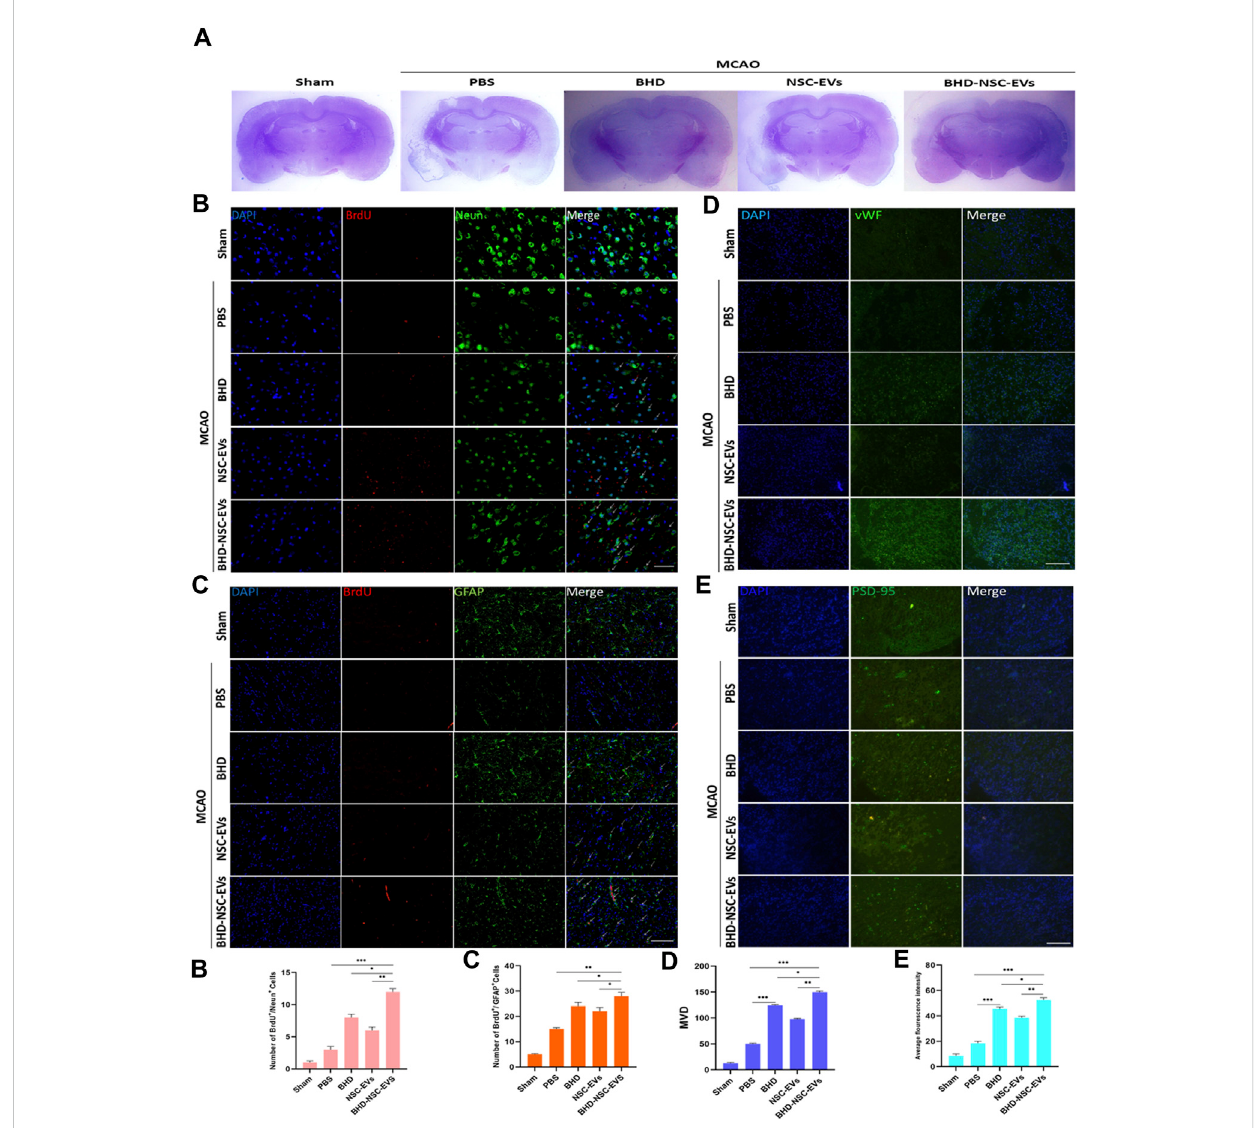
FIGURE 5 BHD-NSC-EVs promoted the neurovascular unit remodeling after stroke. (A) Representative nissl-stained coronal section of cerebral infarcted lesion inMCAO rats. ( n = 7/group) (B-c) Immuno fl uorescentanalysis of neurogenesis ofneurosand glialcells, fl uorescentstainingwith DAPI(blue), BrdU (red),Neun(green)andGFAP(green)revealedneurogenesisof (B-b) neuros(BrdU+/Neun+)and (B-b) glialcells(BrdU+/GFAP+).(n=7/group),* p < 0.05, ** p < 0.01, Scale bar 100 μ m in panel (D) Immuno fl uorescent analysis of neurogenesis of angiogenesis with vWF (green). ( n = 7/group), * p < 0.05, ** p < 0.01, *** p < 0.001, Scale bar 100 μ m in panel (E) Immuno fl uorescent analysis of a marker of synaptic plasticity with PSD-95 (green). (a-d) Quantitative data of number of regenerative cells and fl uorescence intensity of PSD-95 using ImageJ. ( n = 5). NS, not signi fi cant. * p < 0.05, ** p < 0.01, *** p < 0.001. All data are from three independent experiments and are presented as mean ± s.e.m,two-sided Student ’ s t-tests were used for comparisons (b-e)